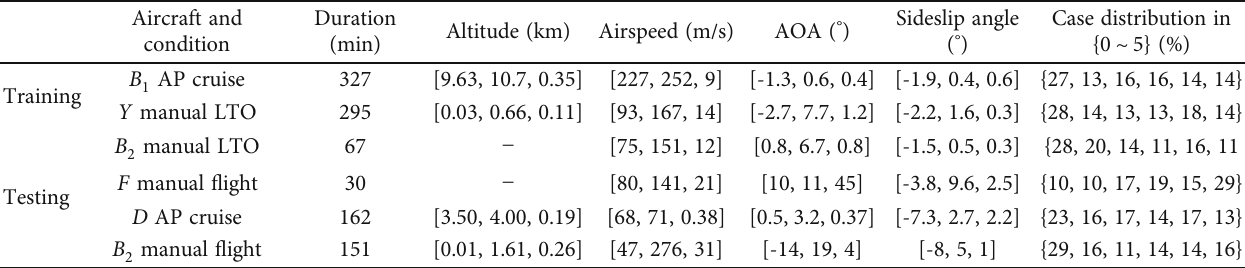
Table 3: Training and testing data speci fi cs in this